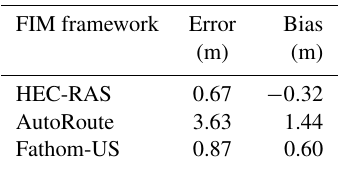
Table 2. Error and bias computed for each FIM framework using observed HWM